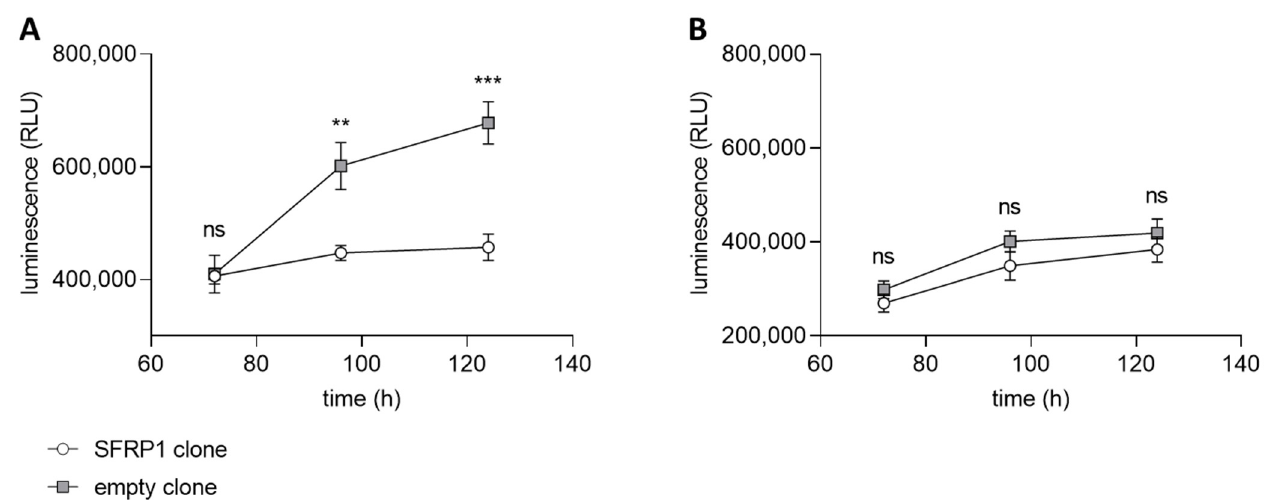
Figure 5. Differential cell viability measurements with SFRP1 as C2TSG. CellTiter-Glo ® assay using the breast cancer cell line MCF7 stably transfected with either SFRP1 gene (circle) or empty vector sequence (square). The luminescence (RLU = relative light units) correlates with the number of viable cells at certain time points in the assay. ( A ) Normal breast cancer cell growth of SFRP1 and empty vector clones treated with 0.5% DMSO as solvent control. As expected, the clone expressing SFRP1 shows considerable growth inhibition compared with the empty vector clone. ( B ) SFRP1 and empty vector clones were treated with 50 µ M WAY-316606, an SFRP1-specific inhibitor. As expected, the growth behavior of the SFRP1-expressing clone now resembles that of the empty vector clone because the function of the SFRP1 tumor suppressor protein is inhibited. (ns: not significant, **: p < 0.01, ***: p <